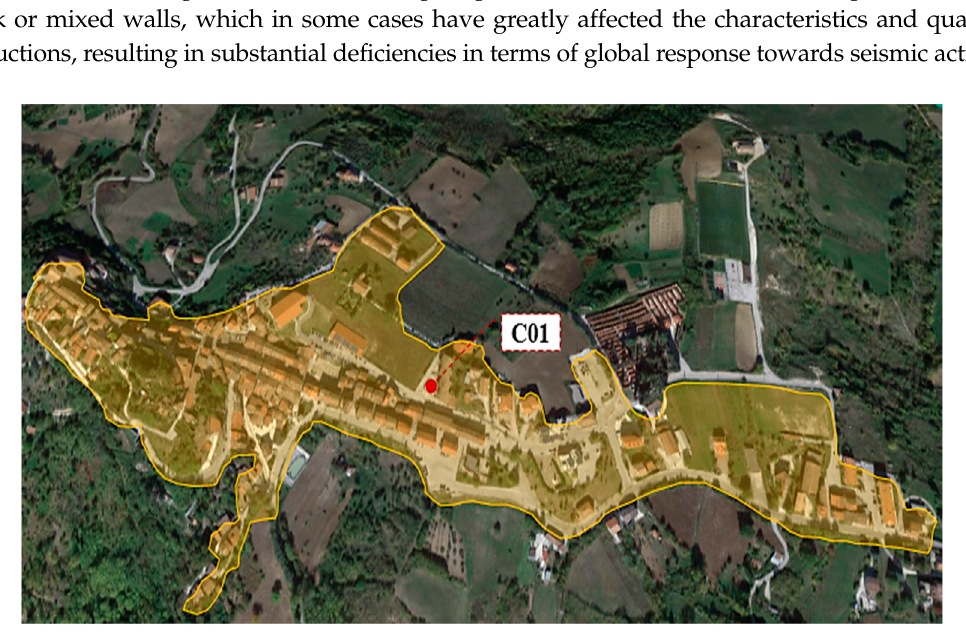
Figure 5. Identification of the urban sector of Baranello.